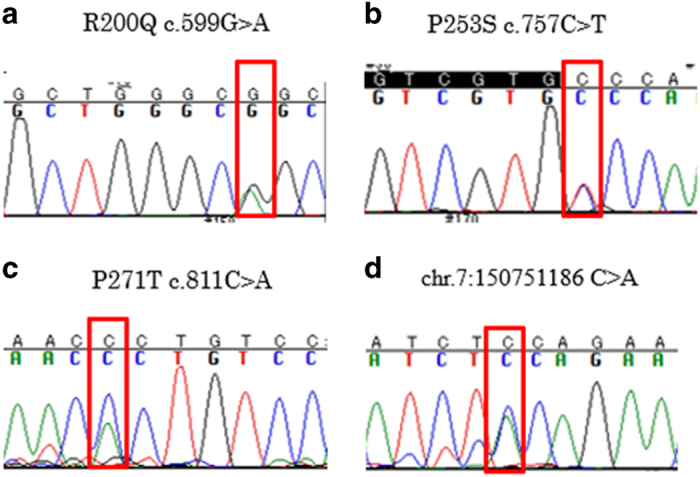
The electropherogram traces of variants confirmed by Sanger sequencing in CDK5. The traces include four novel variants located in the exons of CDK5 (a–c) and one variant in the splice region (d). The locations, nucleotide changes, and consequent amino acid changes are described in the subfigures.